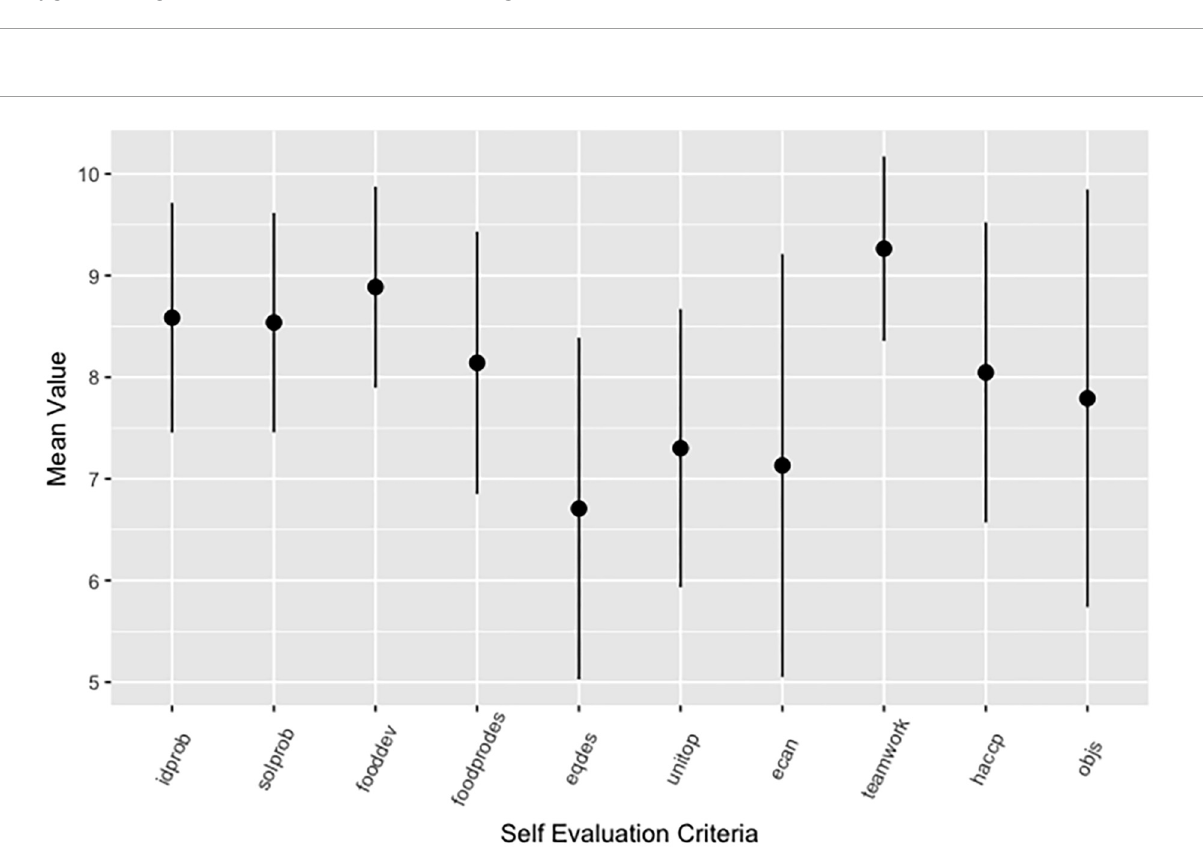
FIGURE2 Self-evaluation means values by category or criteria with standard deviation for all students. The self-assessment used 10 as the highest grade and 1 as the